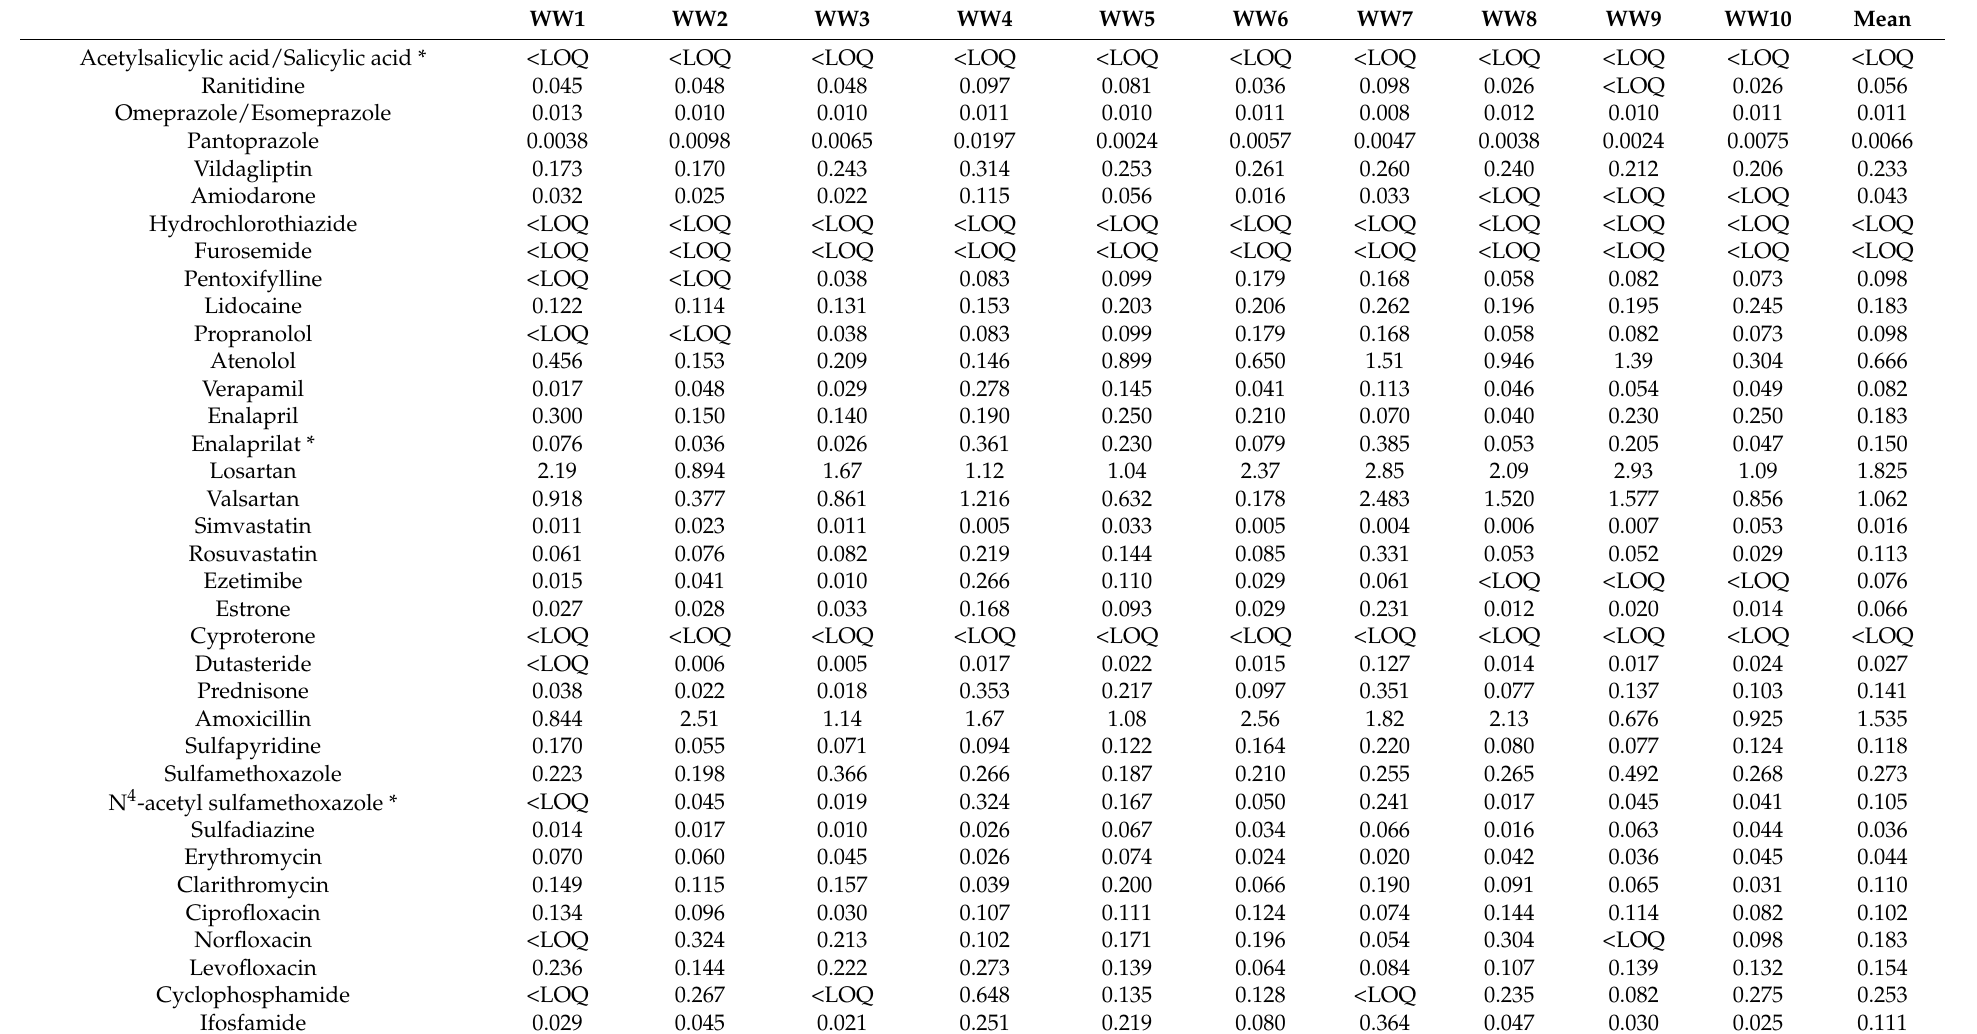
Table 3. Levels of 76 pharmaceuticals, metabolites (*) and TP (**) in effluents of wastewater ( µ g L − 1 ). WW: wastewater.